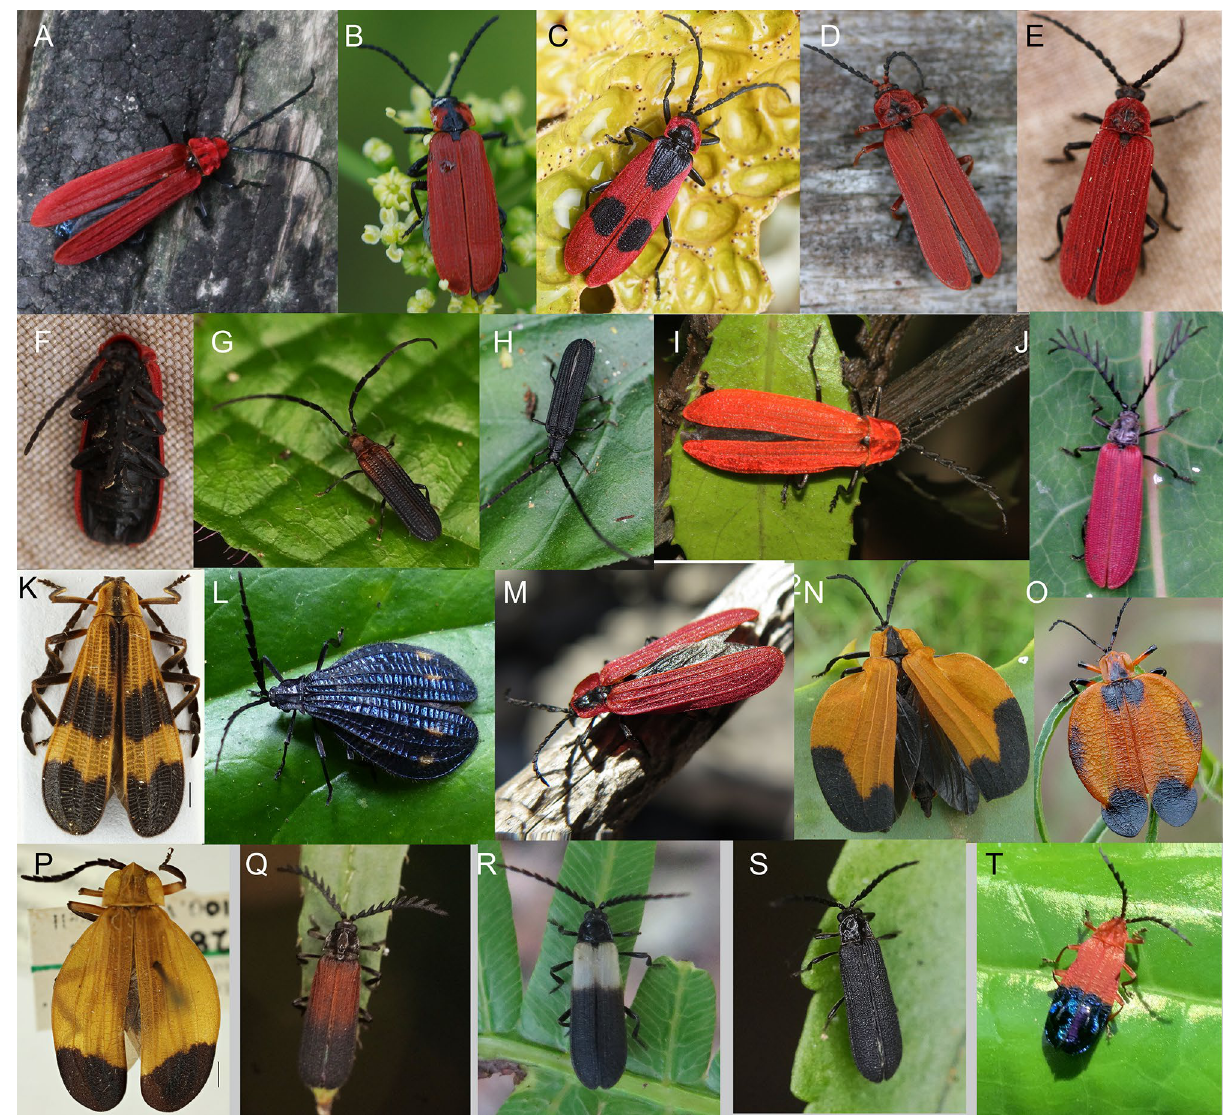
Figure 2. Aposematically coloured Lycidae in nature. ( A ) Calochromus sp., Yunnan. ( B ) Lygistopterus sanguineus , Czech Republic. ( C ) Parantis triguttatus , Yunnan. ( D ) Dictyoptera sp., Yunnan. ( E , F ) Dictyoptera sp., Japan. ( G ) Scarelus umbrosus , Malaya. ( H ) Scarelus anthracinus , Malaya. ( I ) Macrolycus sp., Yunnan. ( J ) Lyponia quadricollis , Japan. ( K ) Calopterini, Ecuador, the photograph from the collection). ( L ) Idiopteron sp., Ecuador, the photograph by M. J. Eising, Utrecht. ( M ) Lycostomus kraatzi , Turkey. ( N ) Lycus sp., the photograph by T. Rulkens, CC BY-SA 2.0. ( O ) Lycus trabeatus , South Africa, the photograph by B. Dupont, CC BY-SA 2.0; ( P ) Neolycus arizonensis, Arizona, the photograph from the collection. ( Q ) Plateros sp., Malaya. ( R ) Plateros sp., New Guinea. ( S ) Plateros sp. Malaya. ( T ) Thonalmus sp., Dominican Republic. If not stated otherwise, the photographs were taken by authors listed under the title of this